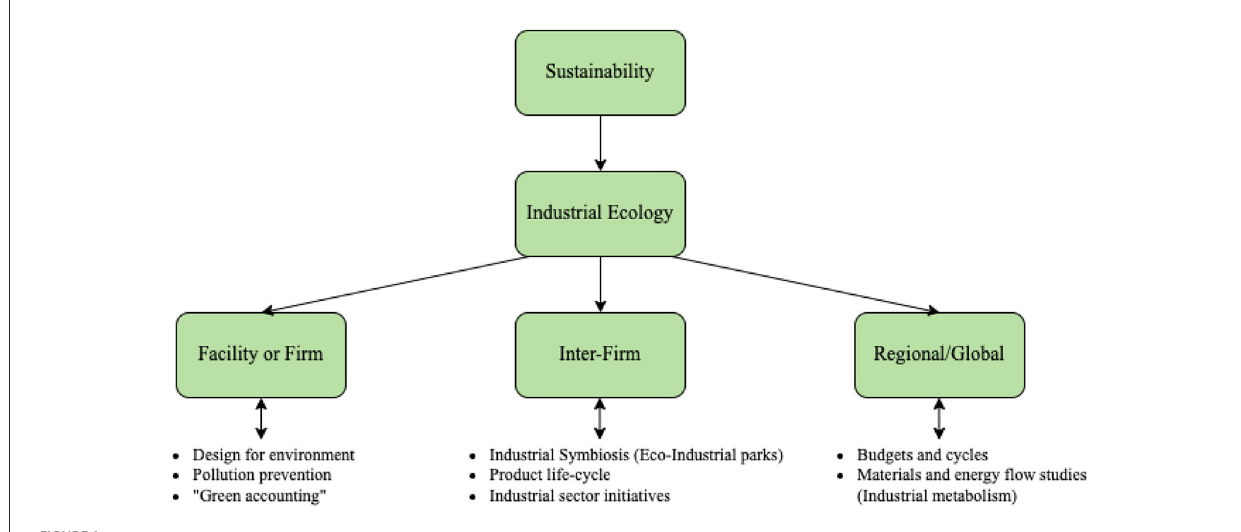
FIGURE1 Industrial ecology structure. Source: Chertow (2000).